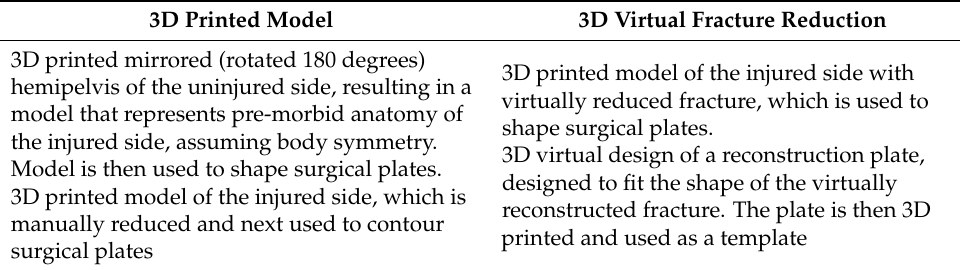
Table 1. Two approaches to preparing 3D printed models as